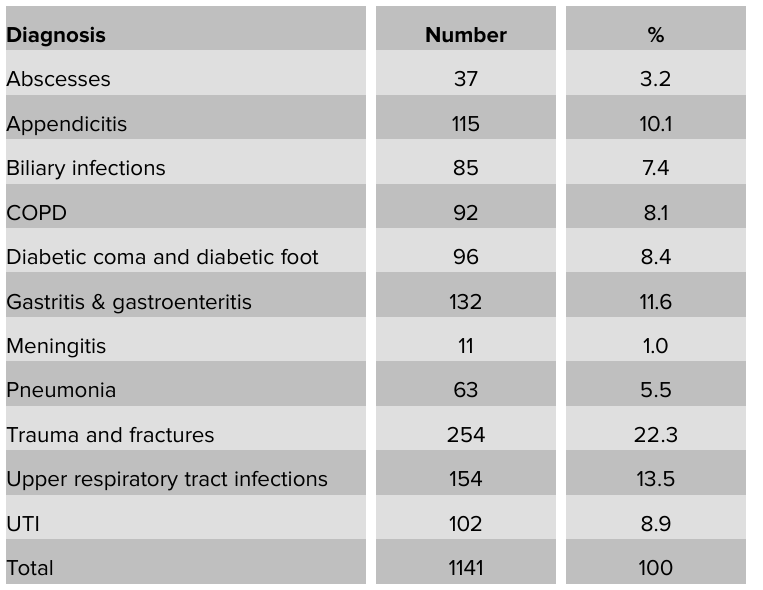
Table 4: Distribution of ceftriaxone encounters (total of 1141), according to